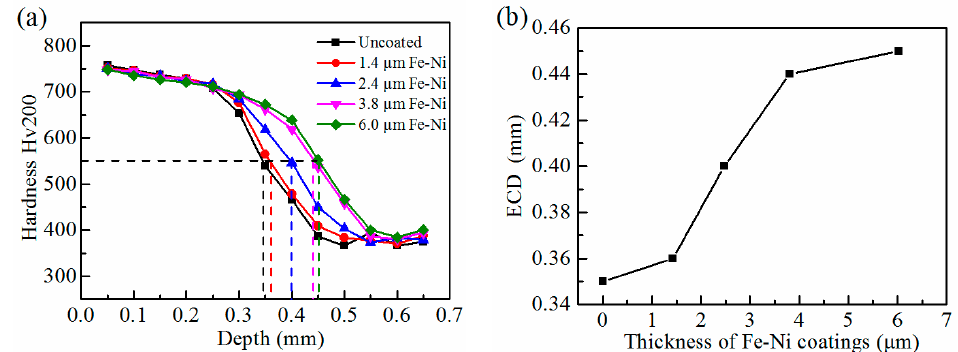
Figure 7. ( a ) Hardness distribution of the samples after hardening treatment; the ECD of the carburized layer is marked in the figure. ( b ) The ECD values as a function of Fe–Ni film